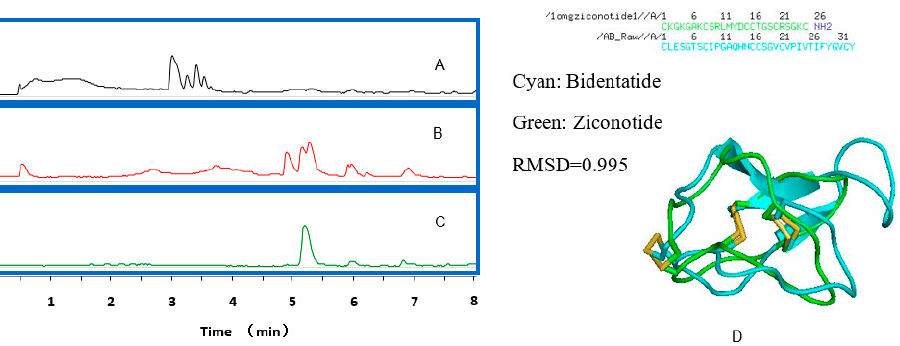
Figure 1. The LC-MS chromatograms of: ( A ) the extract of Achyranthes bidentata Blum using 50% methanol; ( B ) the enriched peptides from Achyranthes bidentata Blum; ( C ) bidentatide after purification; ( D ) the linear sequence of bidentatide and its homologue, ziconotide (up), as well as their simulated 3D structures. Table 1. TCEP/NEM step-by-step reduction of bidentatide to obtain disulfide bond information.